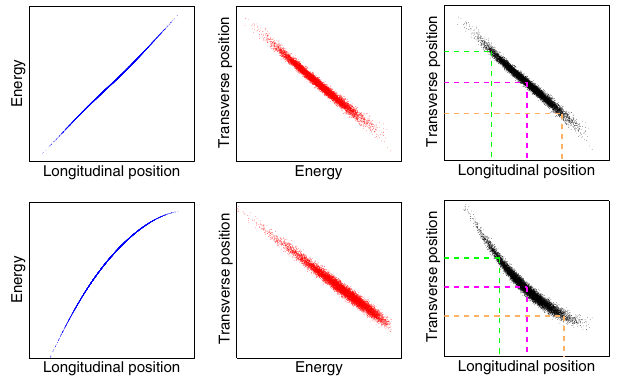
FIG. 1. Beam streaking with dispersion function for an energy- chirped beam (schematic). The combination of an energy chirp (left plots) and transverse dispersion (center plots) results in an effective beam streaking (right plots). The upper plots show the case where the chirp is linear, the lower plots correspond to a nonlinear energy chirp. The dashed lines in the left plots indicate the relation between transverse and longitudinal position for three parts of the bunch which are equally separated in transverse position. Only in the case of a linear energy chirp will the three regions be equally separated in longitudinal position as well, i.e., only a linear chirp results in a linear